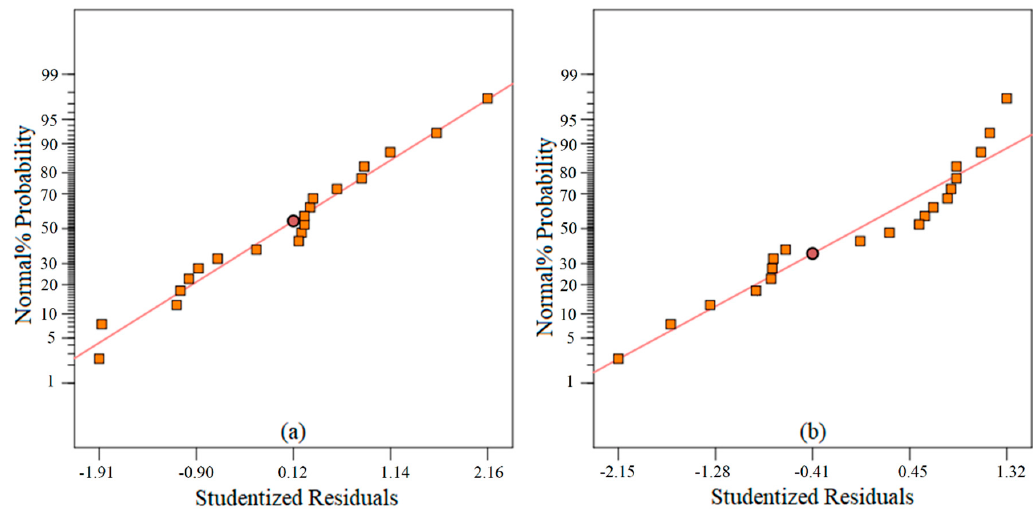
Figure 5. Residual plots for the model developed for ( a ) average surface roughness (Sa); ( b ) maximum roughness height (Sz).